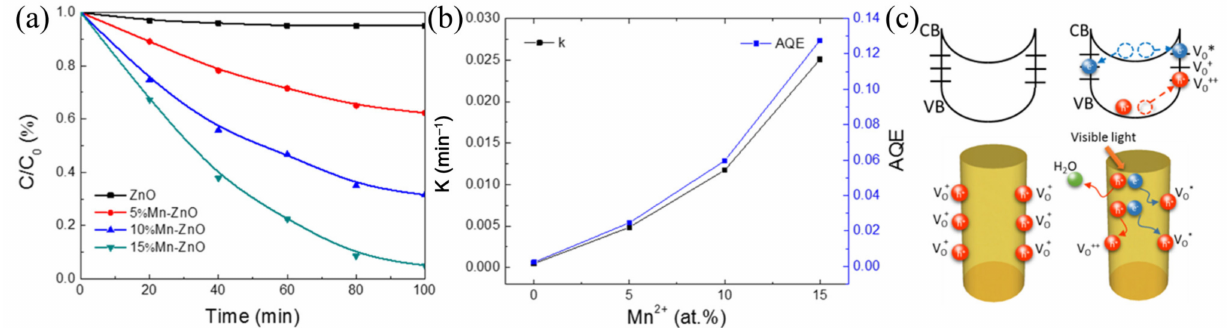
Figure 16. ( a ) Photodegradation of RhB by ZnO nanofibers doped with different Mn 2+ concentrations. ( b ) Degradation rate constants and apparent quantum efficiencies. ( c ) Schematic of trapping and photocatalytic mechanism in a single NF under dark and visible light. (Redrawn with the permission of Ref. [54]. Copyright 2016 Wang, Y. et